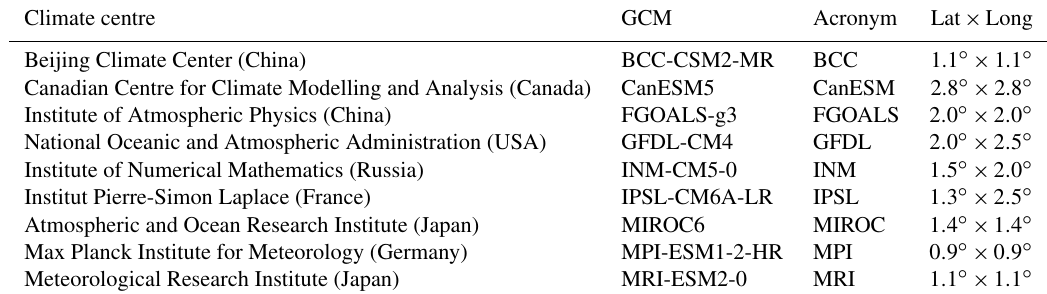
Table 1. The CMIP6 GCMs used in this study. The columns contain, from left to right, the name of the research centre developer of the GCM, the name of the GCM, the acronym used in this study, and the resolution of the Z500 output. All data were provided by the Mésocentre